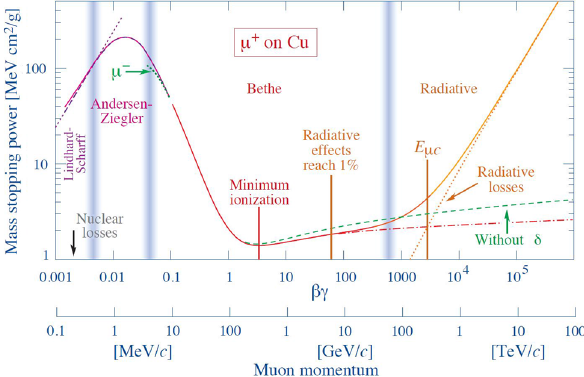
Fig. 1 Mass stopping power for muons in the 0.1 MeV to 100 TeV range, in MeVcm 2 / g. The rise in radiative loss becomes important above 100 GeV. Image reproduced with permission from Ref.